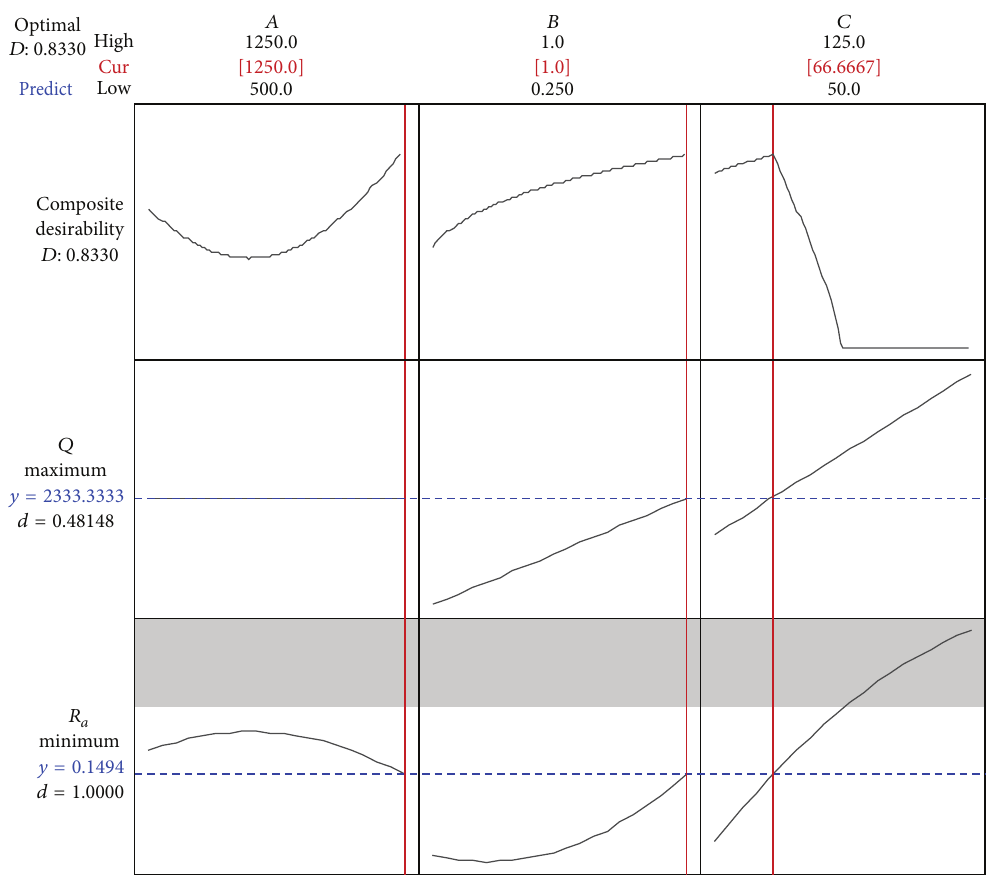
Figure 13: Multiobjective optimization plot for 𝑅 𝑎 and metal removal rate (𝑄) .